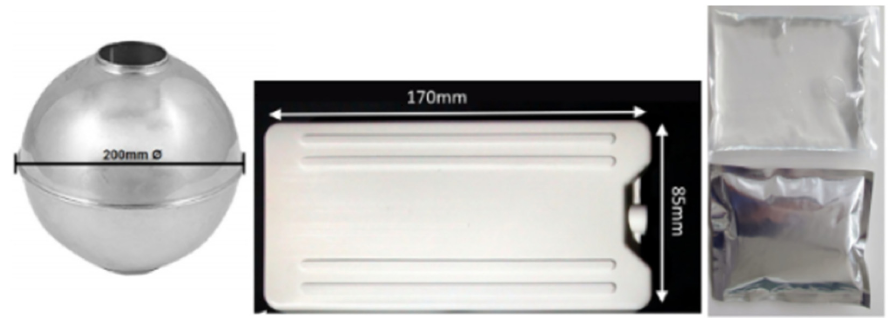
Figure 16. Commercially available PCM macro-capsules: spheric ( left ), flat containers and bags ( right ), Mehling et al. [148]. Reproduced with permission from Elsevier.